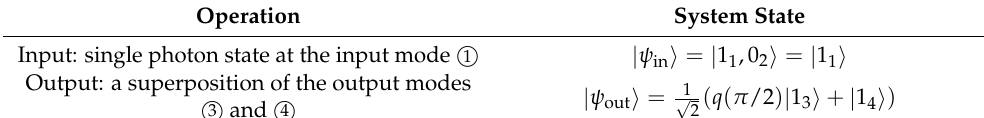
Table A2. Preparation of the quantum state at the bare beam splitter. See text and Figure A4 for details. Operation